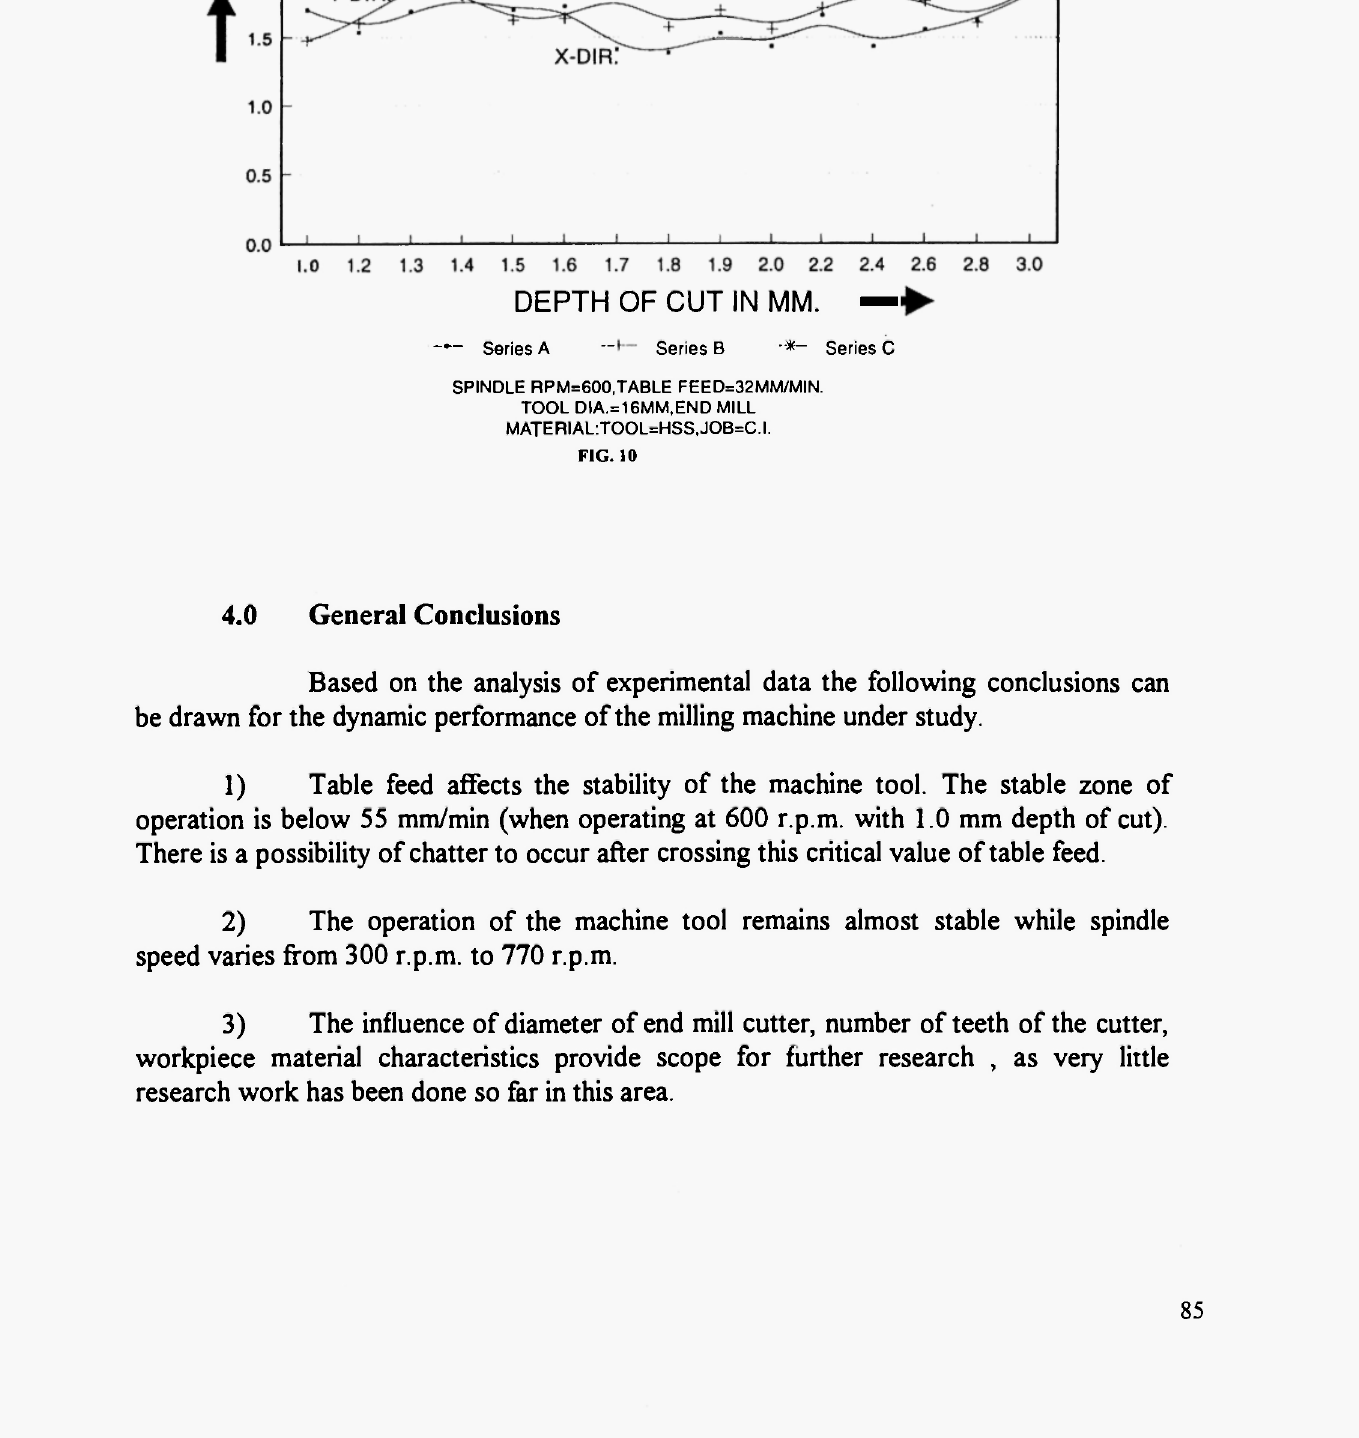
MATERIAL:TOOL=HSS,JOB=C.I. FIG.